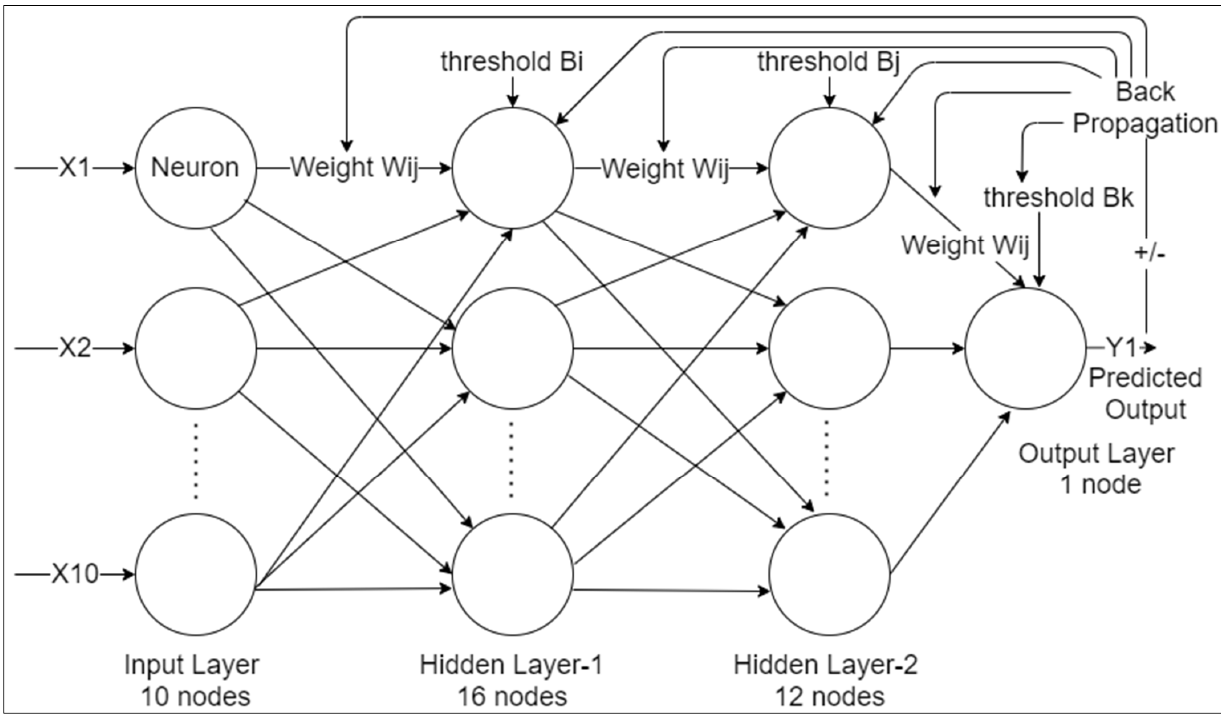
Figure 11. The architecture of the backpropagation neural network.